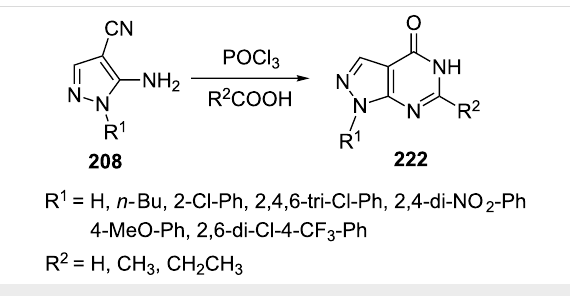
Scheme 58: Synthesis of 1-(2,4-dichlorophenyl)pyrazolo[3,4- d ]pyrimidin-4-yl carboxamides.